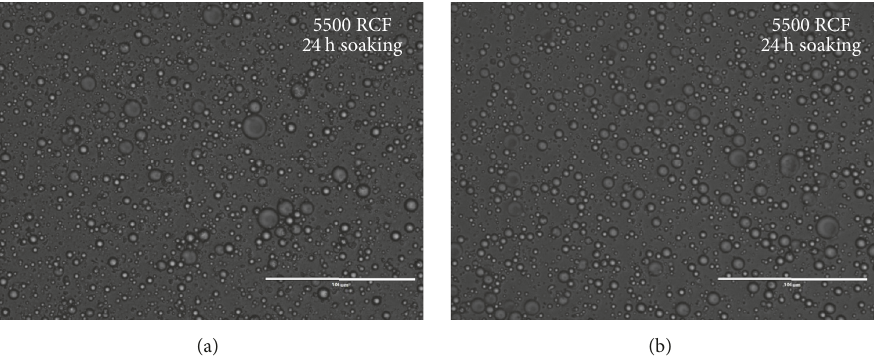
Figure 12: Light micrographs of (a) crude oil body (COB) and (b) washed oil body (WOB) emulsions of opalescent pecan